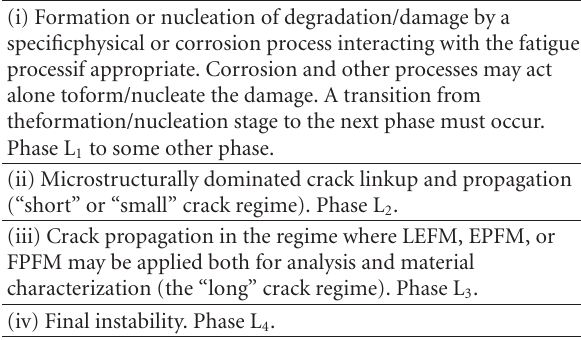
Table 1: Phases of Life. See Figure 1. from Hoeppner, 1972 [67], 1981 [38], 1985 [39].